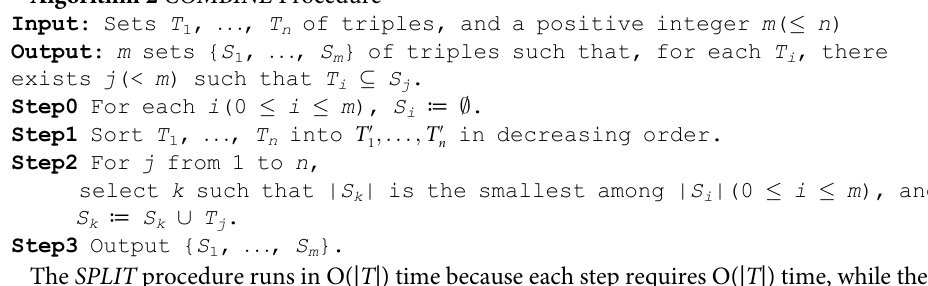
Algorithm 2 COMBINE Procedure